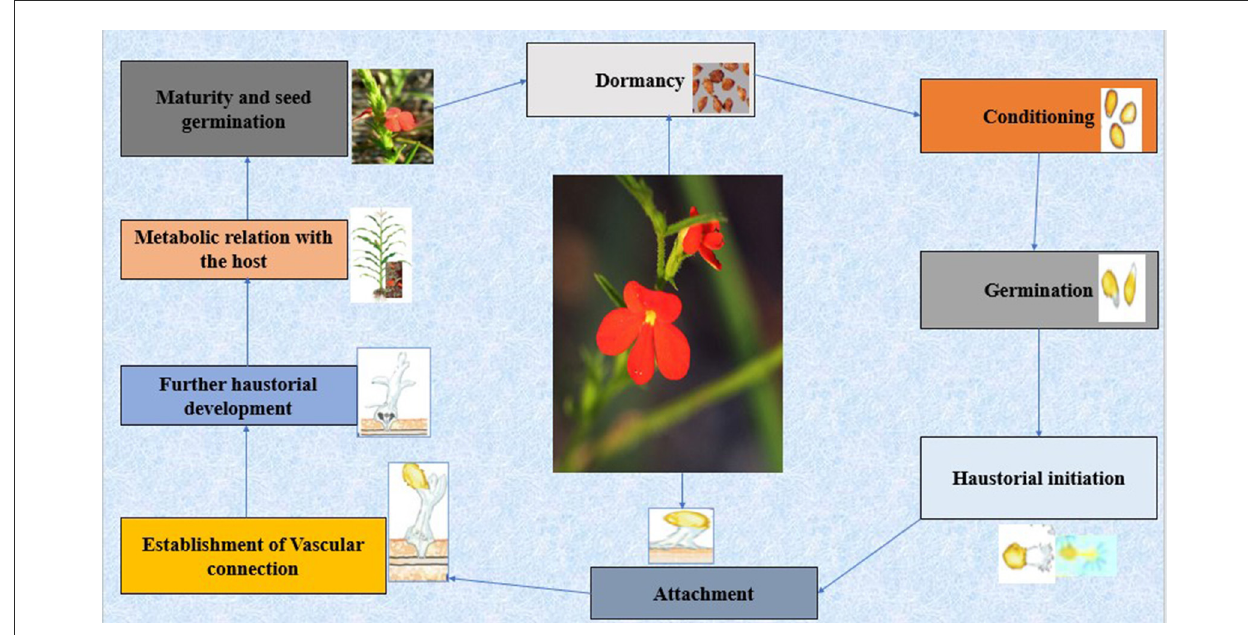
FIGURE1 Scheme showing the establishment and life cycle of Striga spp. ( Striga asiatica (L.) Kuntze).